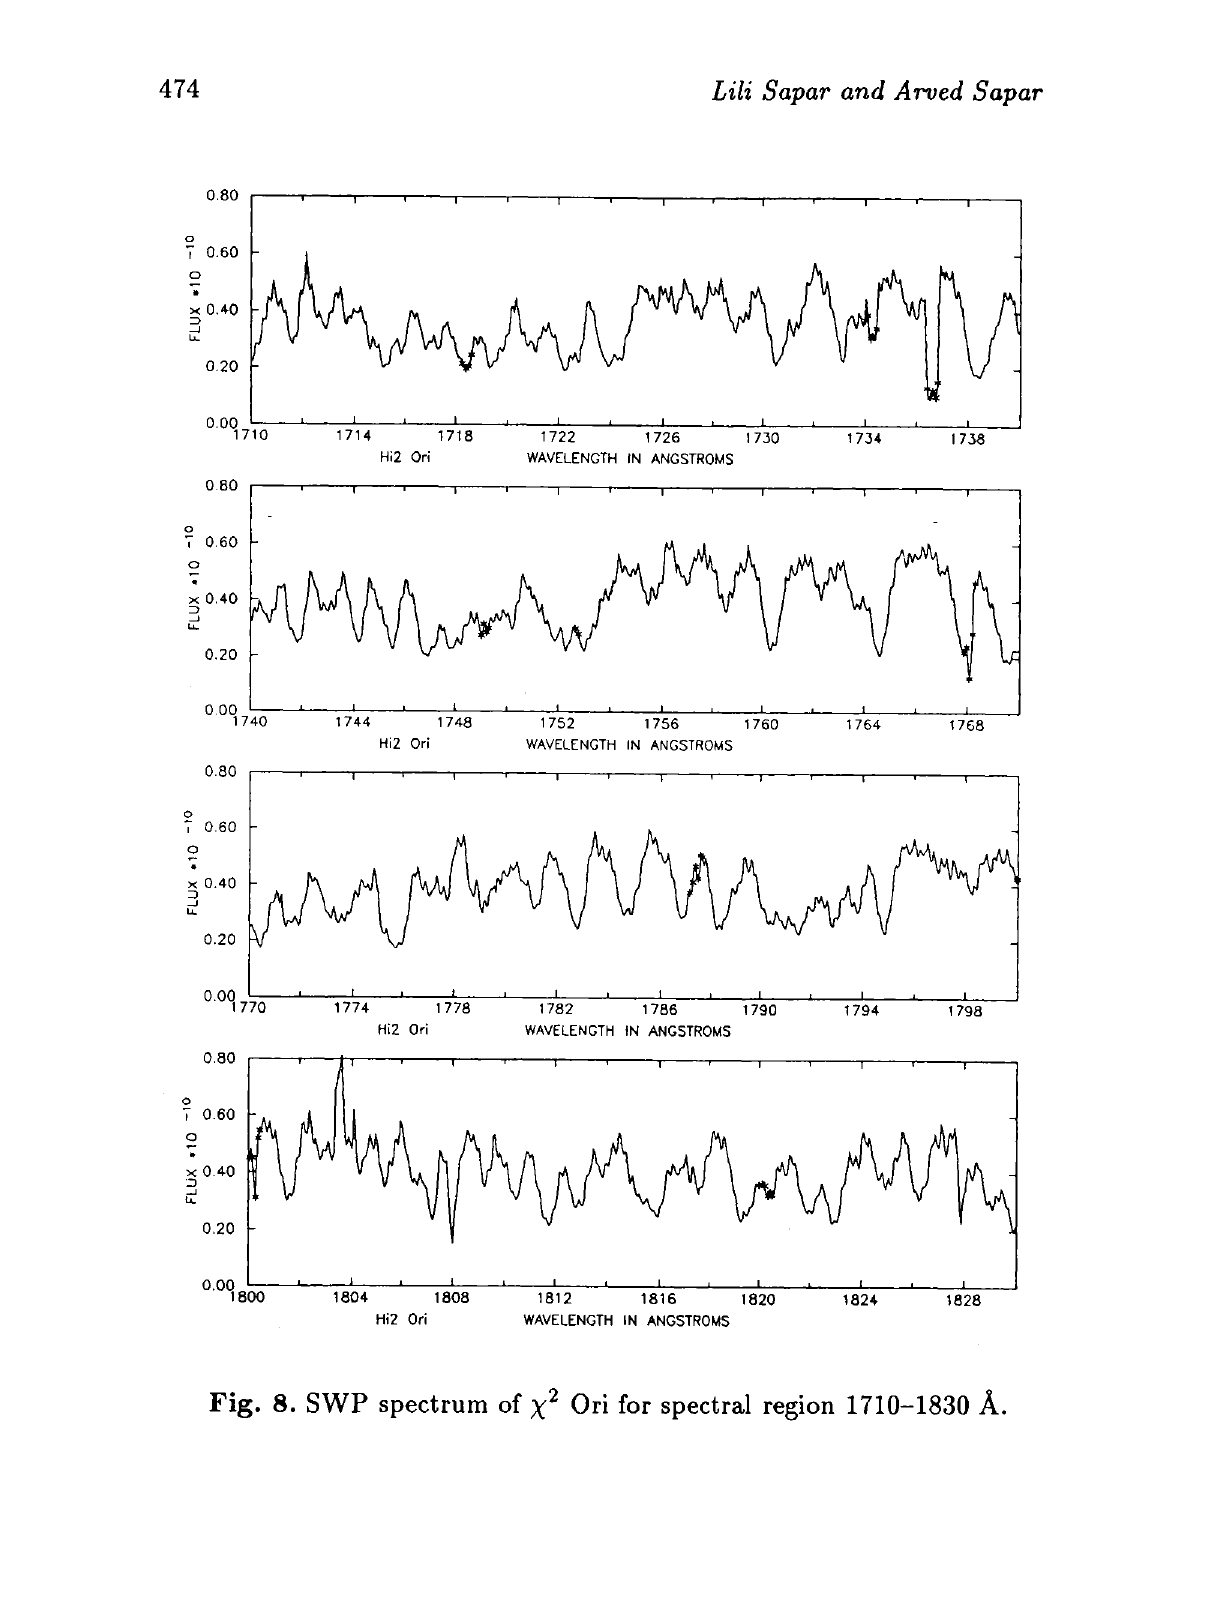
Fig. 8. SWP spectrum of x 2 Ori for spectral region 1710-1830